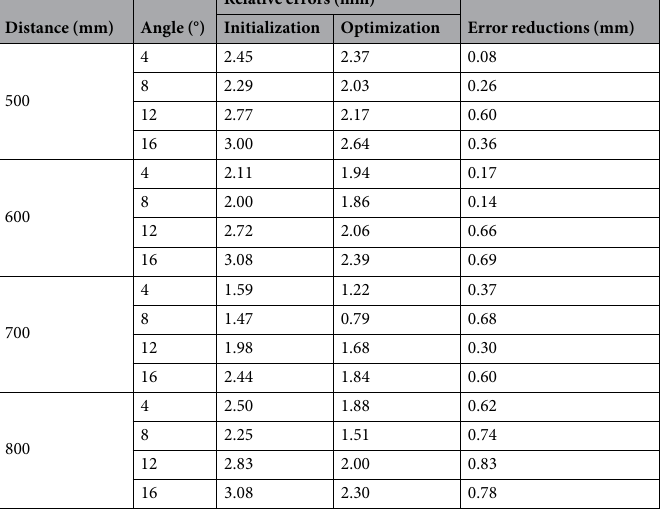
Table 1. The error reductions of the optimization method relative to the initialization method, under the measurement distances of 500 mm, 600 mm, 700 mm, 800 mm, and the measurement angles of 4°, 8°, 12°,